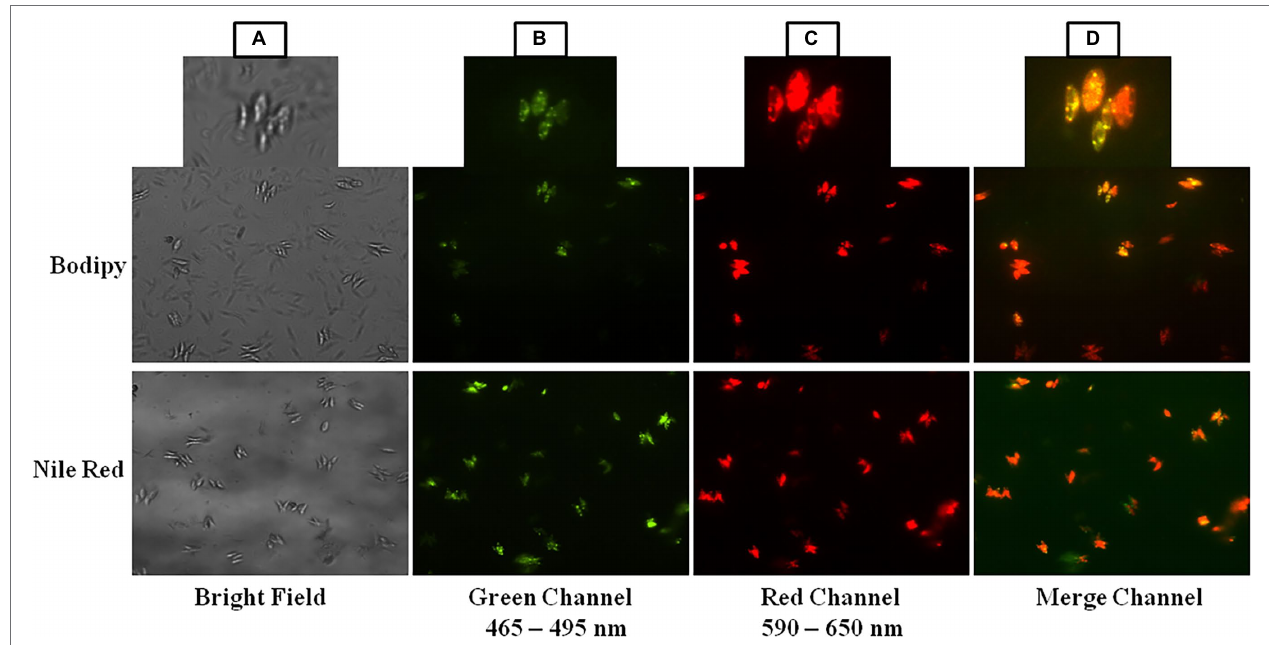
FIGURE 8 | BODIPY 505/515 and Nile Red stained cells of Scenedesmus sp. BHU1 under fluorescence microscope in different